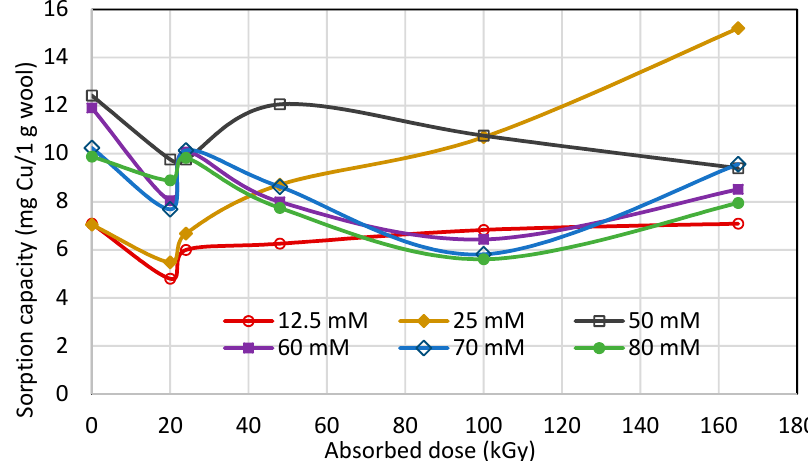
Figure 7. Variation of Cu(II) sorption onto irradiated sheep wool depending on absorbed dose for different Cu(II) bath concentration.